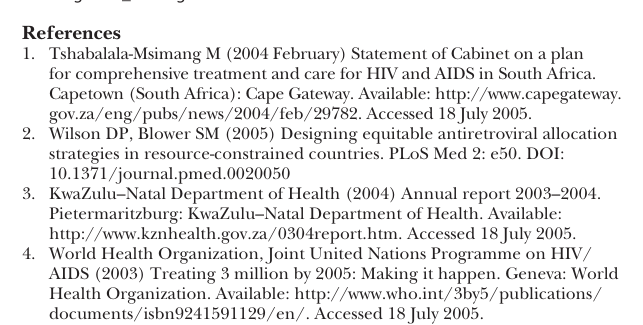
Table 1. Number of ART HCF Calculated for Each District District Population HIV Population